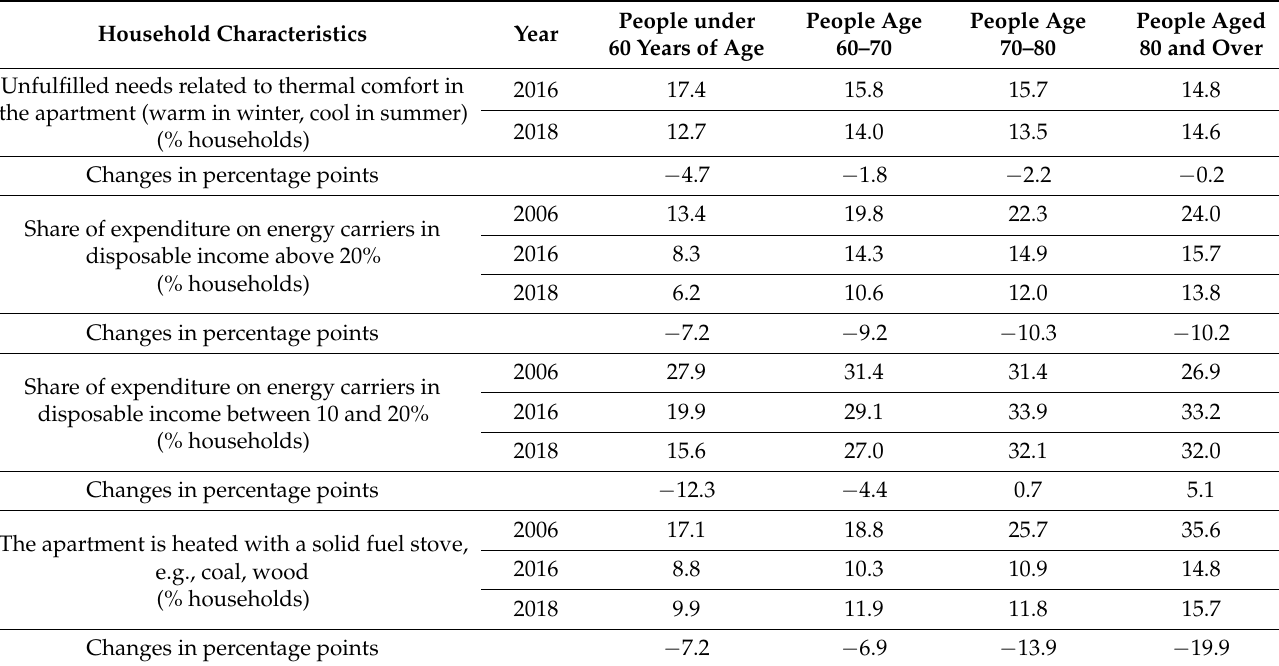
Table 3. Comparison of conditions in terms of energy carriers in households by age of the person running the household in 2006, 2016 and